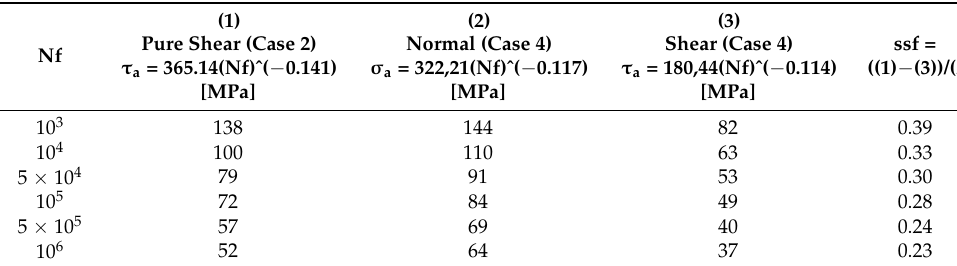
Table 7. ssf results for Case 4—AZ31B-F.